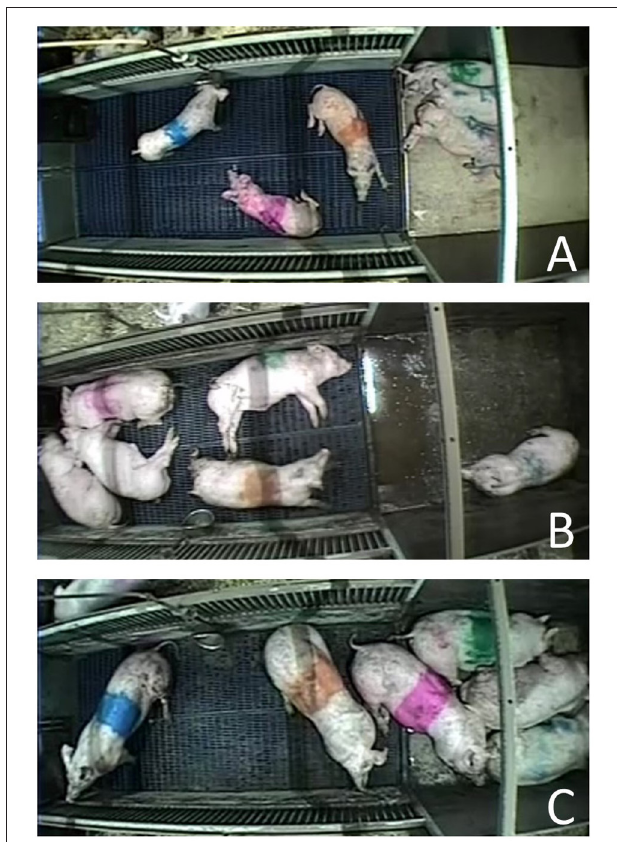
FIGURE 8 | Example frames of young detection model (A) , test video (B) , and old detection model (C) .